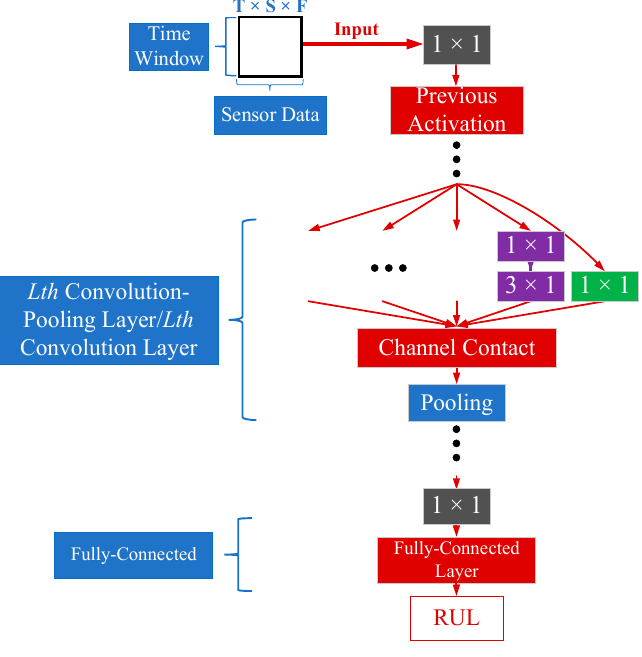
Figure 5. The proposed network.